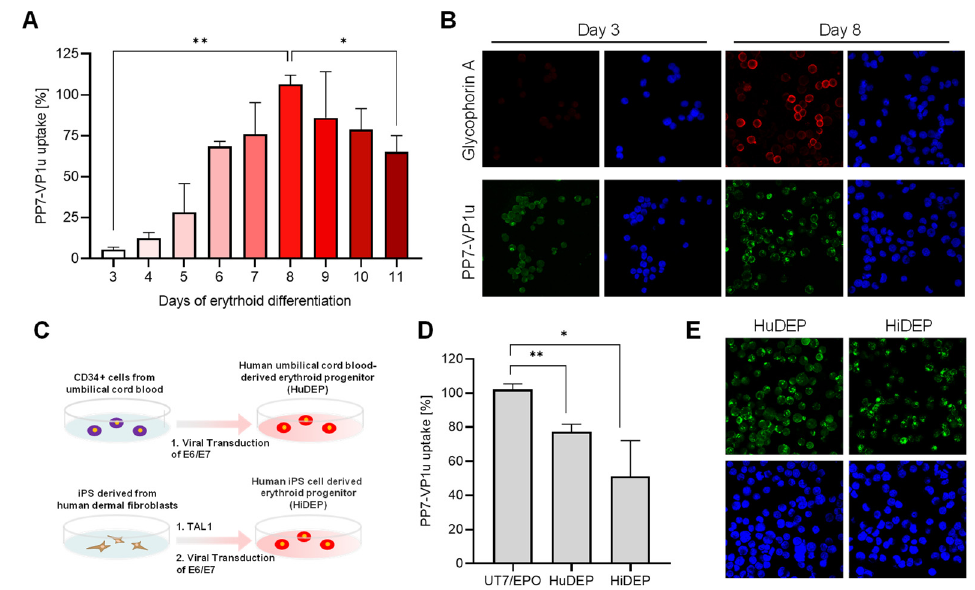
Figure 4. VP1uR expression is upregulated during erythroid differentiation. ( A ) EPCs at progressive differentiation phases were incubated with PP7-VP1u for 30 min at 37 °C and quantified by RT-PCR. ( B ) Confocal microscopy images of EPCs at days 3 and 8 of erythroid differentiation. Cells were incubated with PP7-VP1u or immunostained with a glycophorin A antibody. ( C ) Schematic depiction of the erythroid reprogramming strategy [41]. ( D ) PP7-VP1u bioconjugates were incubated with HuDEP and HiDEP cells for 30 min at 37 ◦ C. Internalization was quantified by RT-qPCR and compared with UT7/Epo cells. ( E ) Representative images of HuDEP and HiDEP cells incubated with PP7-VP1u and visualized by confocal microscopy. The quantitative RT-PCR results are presented as the mean ± SD of two ( A ) or three ( D ) independent experiments. ** p < 0.01; * p < 0.05.